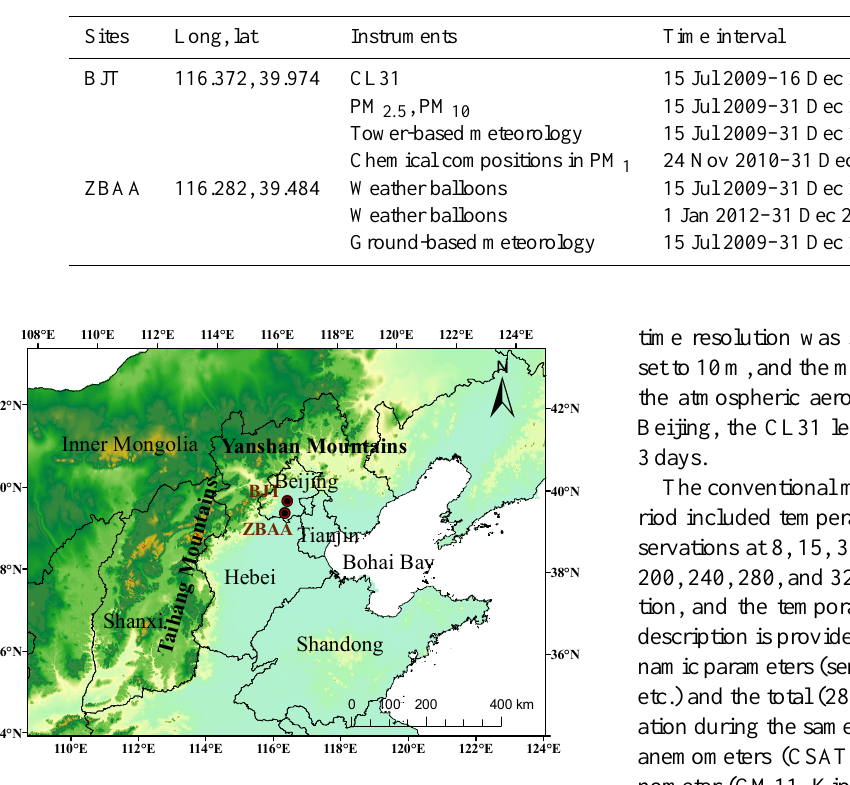
Figure 1. Topography and the observation